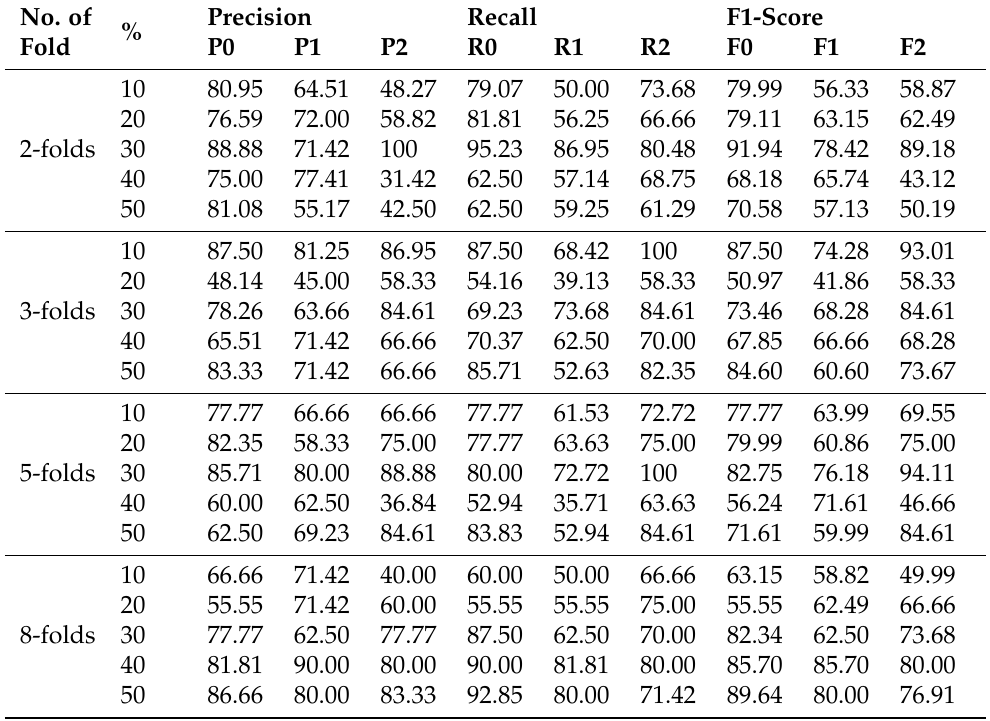
Table 5. Redundant frame with